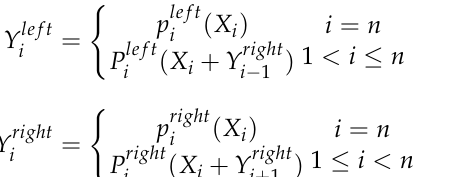
indicates the output of the left, and Y right